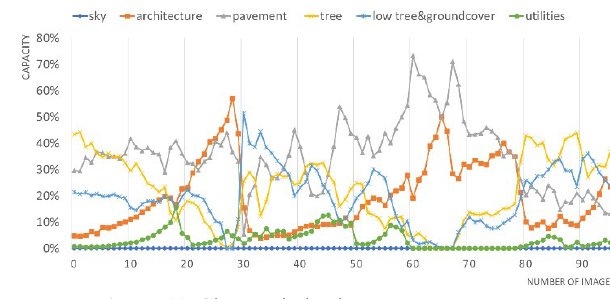
Figure 11 . Changes in landscape components